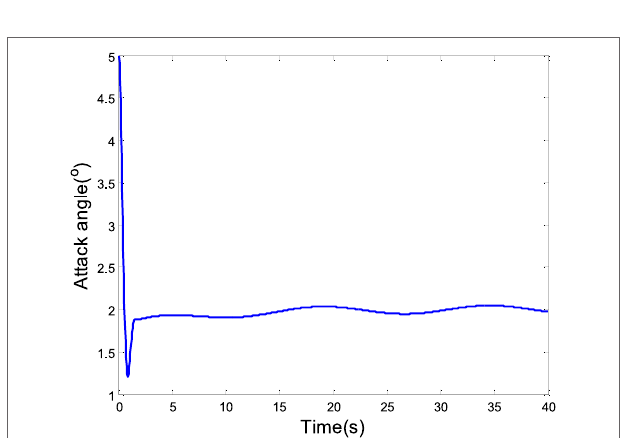
FIGURE 7 | Tracking attack angle.